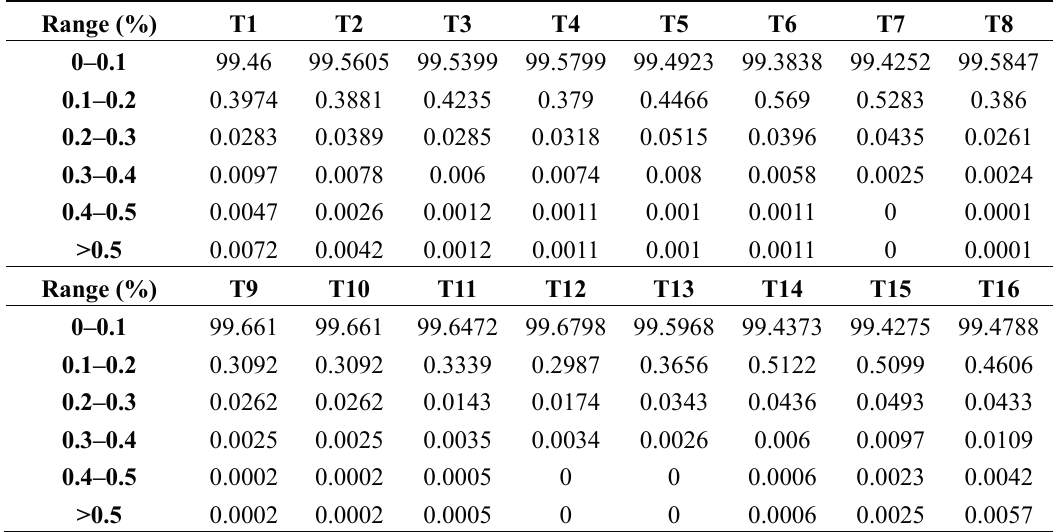
Table 5. Distribution range of the 2010 residuals.